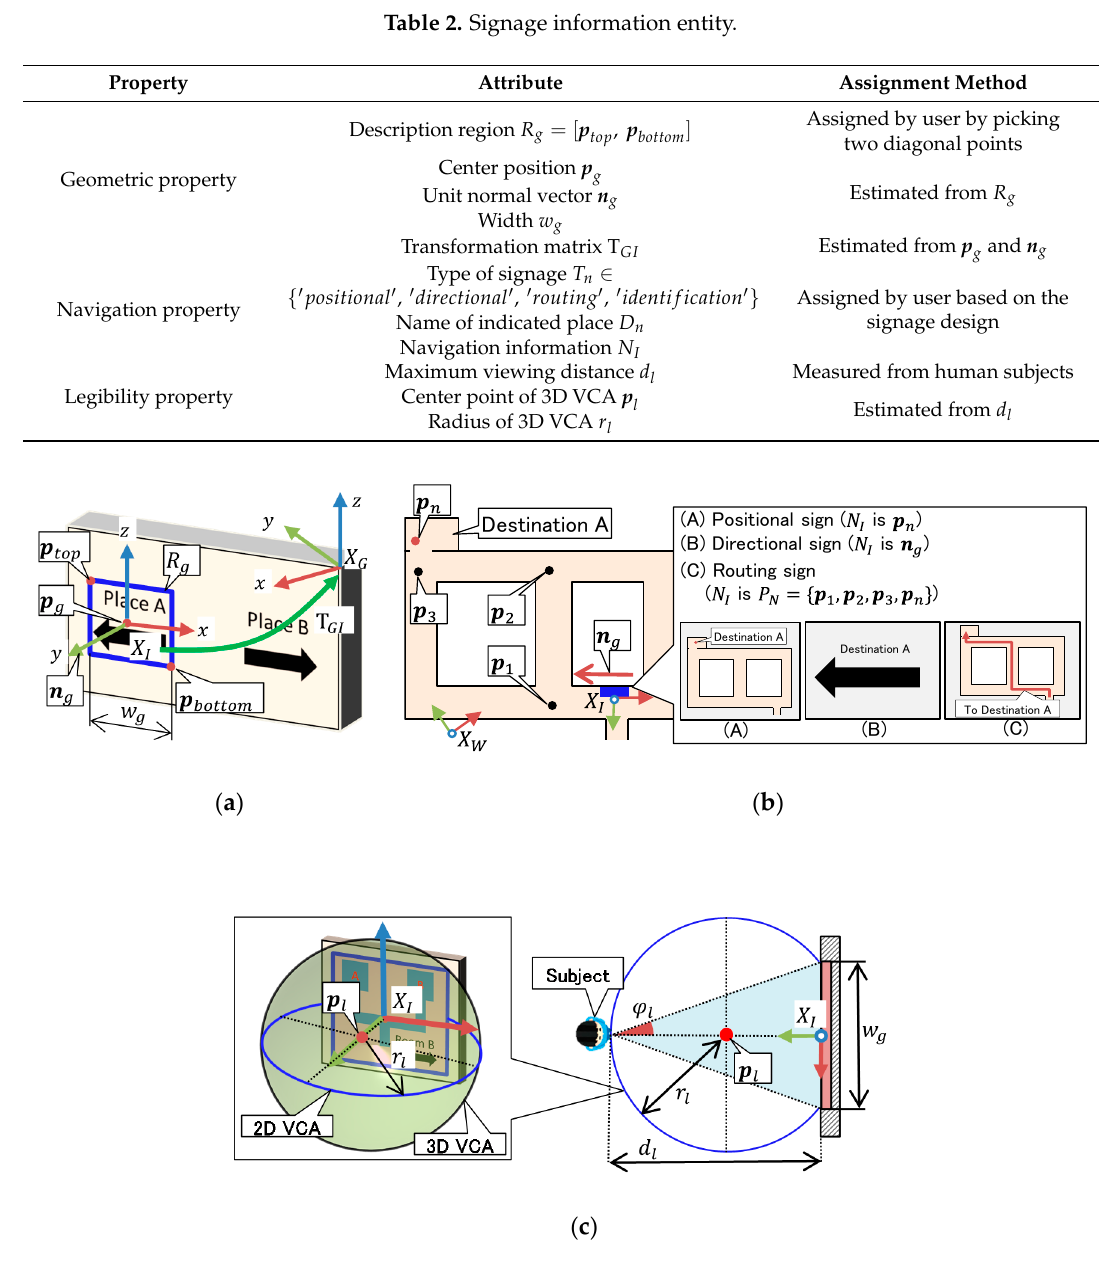
Figure 3. Overview of signage information: ( a ) Geometric property; ( b ) navigation property; ( c ) legibility property.